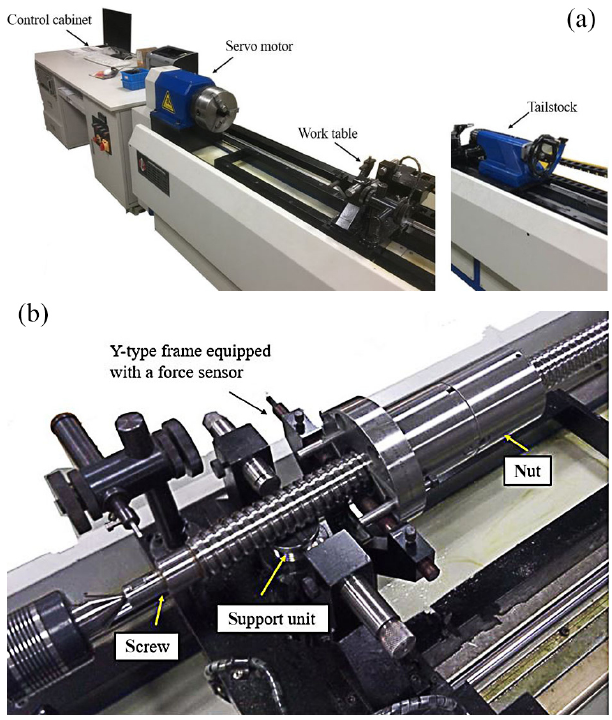
Figure 4. Friction torque test machine.